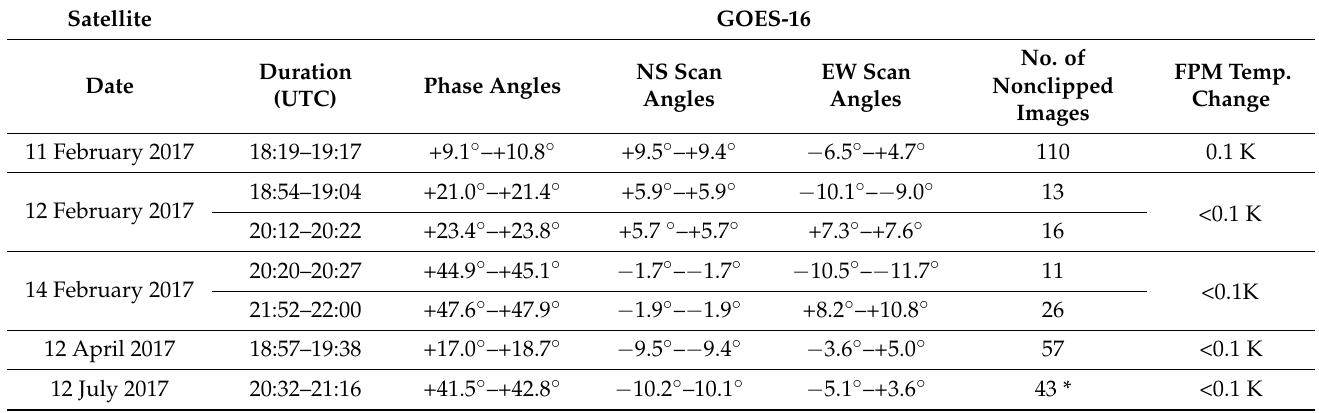
Table 2. GOES-16 lunar chasing information. The B01 central moon locations are used to represent the EW scan